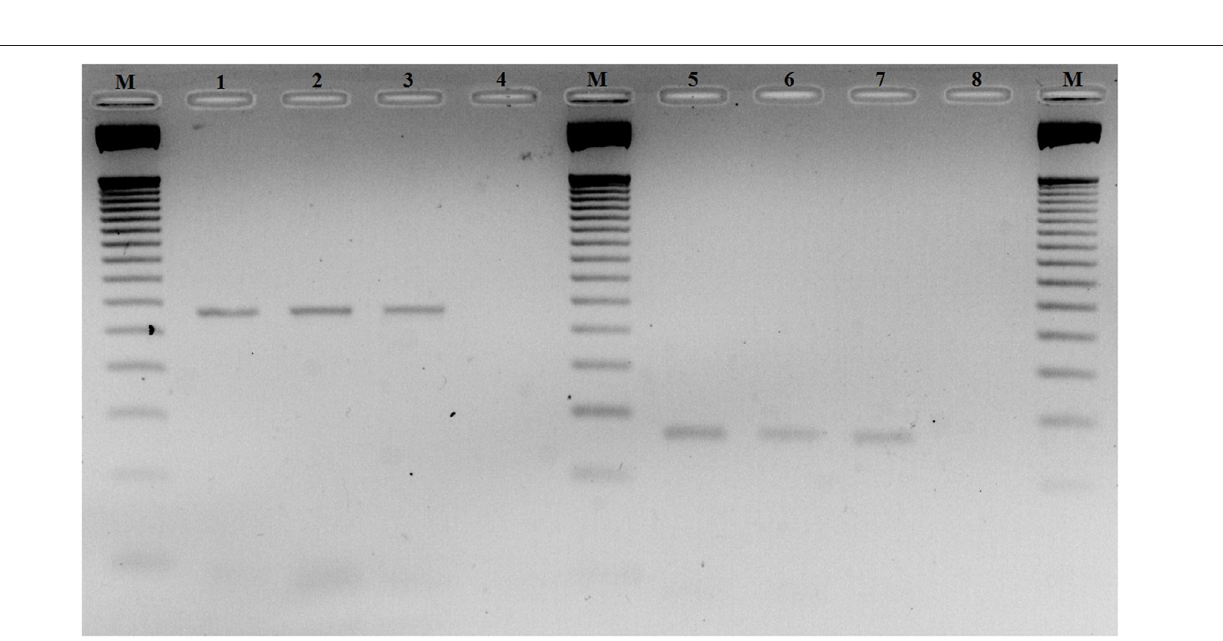
FIGURE 2 | Agarose gel electrophoresis of RT-PCR products of exon 54 Cadherin 23 ( CDH23 ) gene (NM_022124). Lanes M: 50-pb DNA molecular weight markers. Lanes 1, 2 and 3: RT-PCR products using primer-pairs 1 with different ages 60, 64 and 70 years old, respectively. Lanes 5, 6 and 7: RT-PCR products using primer-pairs 2 with different ages 60, 64 and 70 years old, respectively. Lanes 4 and 8: negative controls primer-pairs 1 and 2,